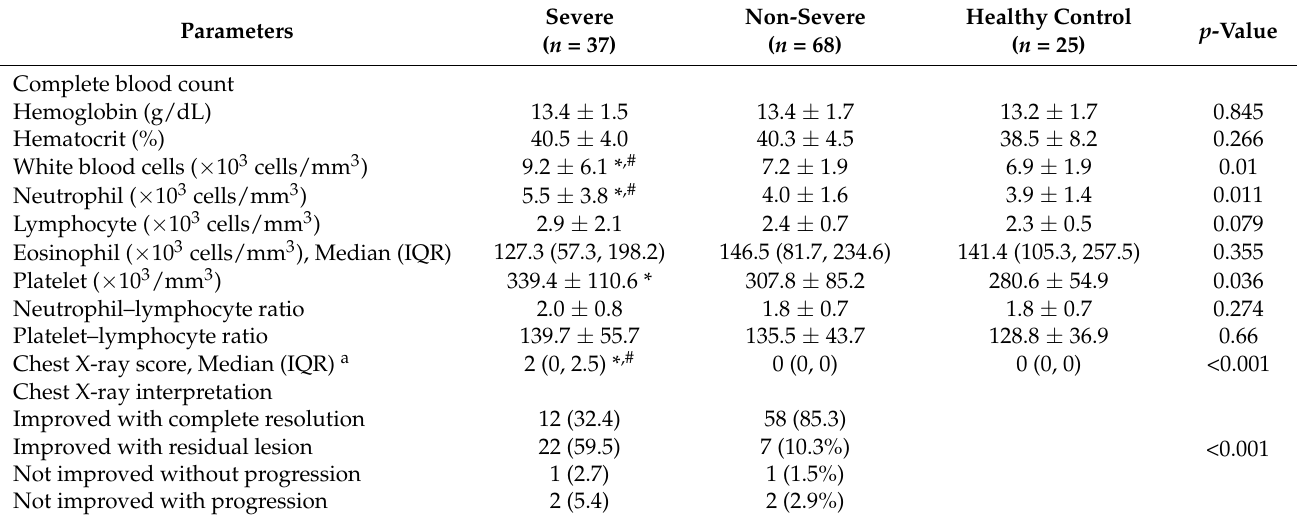
Table 5. Laboratory results and chest radiograph at one-month follow-up